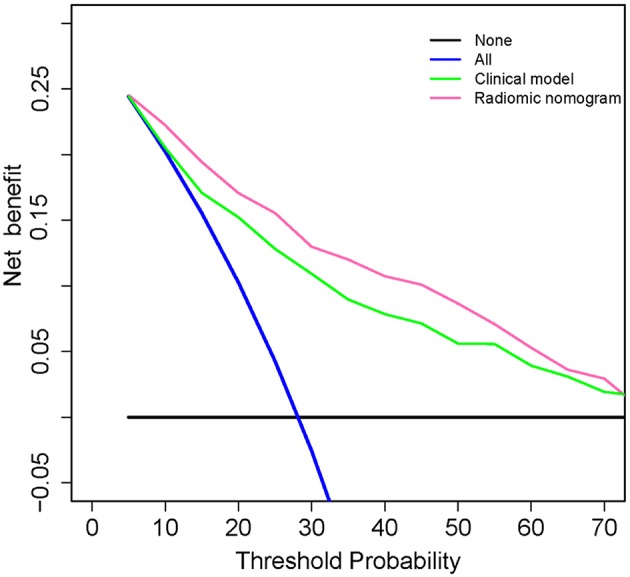
Decision curve analysis for clinical and radiomic nomograms. The black solid line represents the assumption that all patients with PTC do not have ETE. The blue solid line represents the assumption that all patients with PTC have ETE. The green solid line represents the assumption that patients with PTC will be judged positive if the positive probability obtained from clinical nomogram is higher than the threshold probability. The red solid line represents the assumption that patients with PTC will be judged positive if the positive probability obtained from the radiomic nomogram is higher than the threshold probability. The decision curves showed that when the threshold probability is in a reasonable range, the radiomic nomogram provided the greatest net benefit when compared with the treat-all-patients approach, treat-none approach, and the clinical nomogram for predicting ETE status of patients with PTC. ETE, extrathyroidal extension; PTC, papillary thyroid carcinoma.